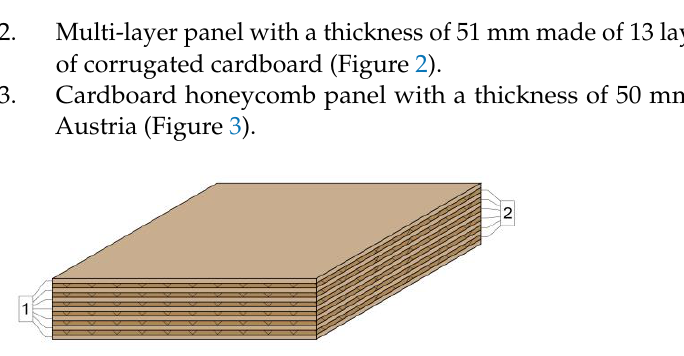
Figure 1. Multi-layer panel with a nominal thickness of 21 mm made of 7 layers of veneer and 6 layers of corrugated cardboard: 1. Rotary cut beech veneer, δ = 1.2 mm; 2. three-layer corrugated cardboard δ н = 6 mm.